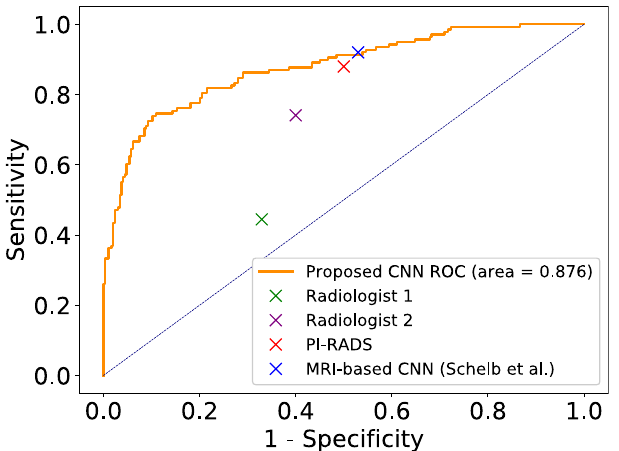
Figure 6. ROC Curve of the proposed CNN model in comparison to the sensitivity and specificity of the two radiologists, PI-RADS, and deep learning systems on MRIs by Schelb et